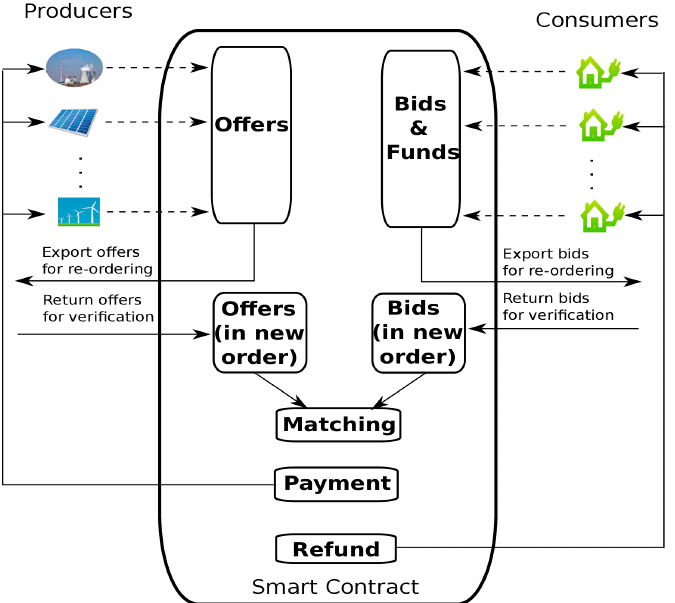
Figure 2. Systematic smart contract-based double auction P2P energy trading scheme (smart contract A). Energy sellers/buyers submit their offer/bid to the smart contract (F4/F6). Buyers make payment to the contract while submitting bid (F6). Offers/bids are sent outside the contract for re-ordering, and sent back into the contract (F5/F7) which then matches sellers and buyers using a double auction mechanism (F8). The contract pays successful sellers and refunds unsuccessful bidders (F9/F10).